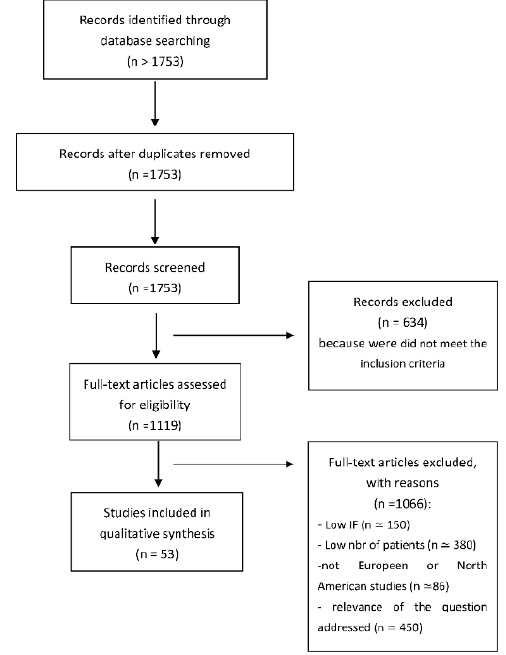
Figure 1. Flow Chart.